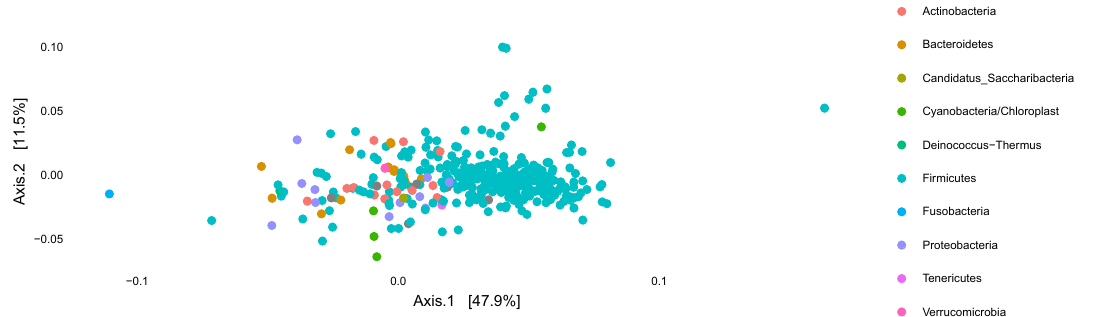
Bacteroidetes Candidatus_Saccharibacteria Cyanobacteria/Chloroplast